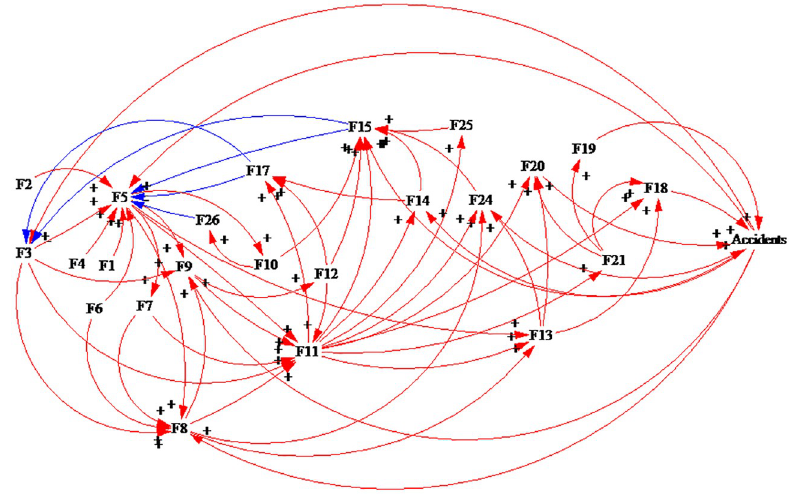
Fig 5. The coping paths of HATC accidents.